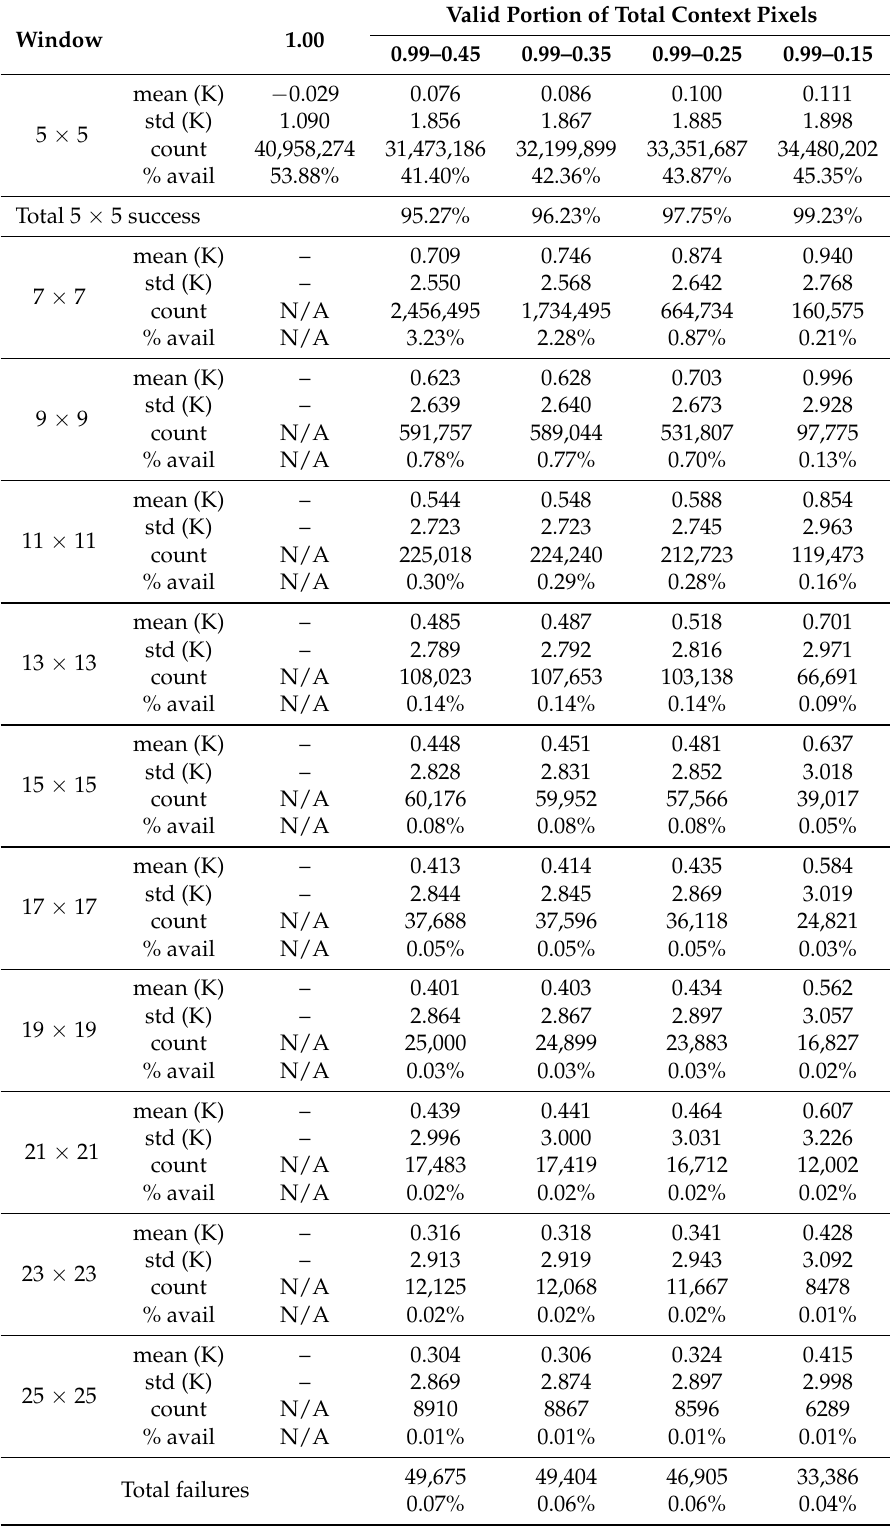
Table 6. Mean and standard deviation of brightness temperature differences between the central pixels and the contextual surrounds at each window level per percentage level, or where the number of context pixels reaches 10. The 5 × 5 window statistics show the global rates for pixels which have equal or greater contextual pixels than the minimum for estimation. The rows for each window size describe the number of calculated values that would be added by expanding to each window size, and the subsequent means and variances of pixels included from these window